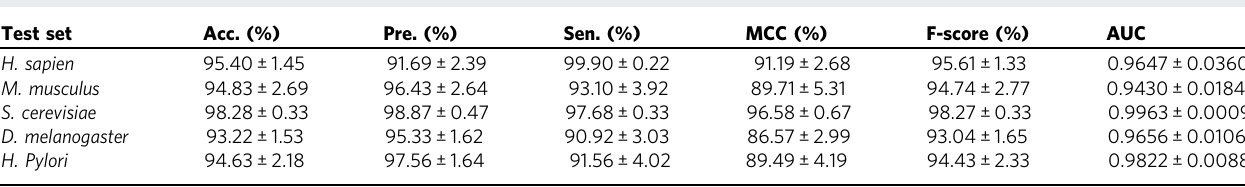
Note: The values in the table are average±standard